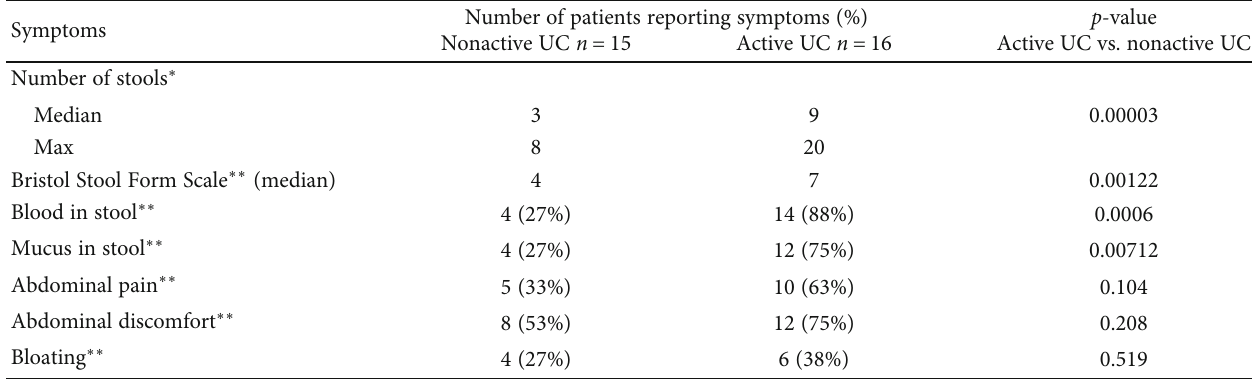
Table 1: Bowel symptoms in patients with ulcerative colitis